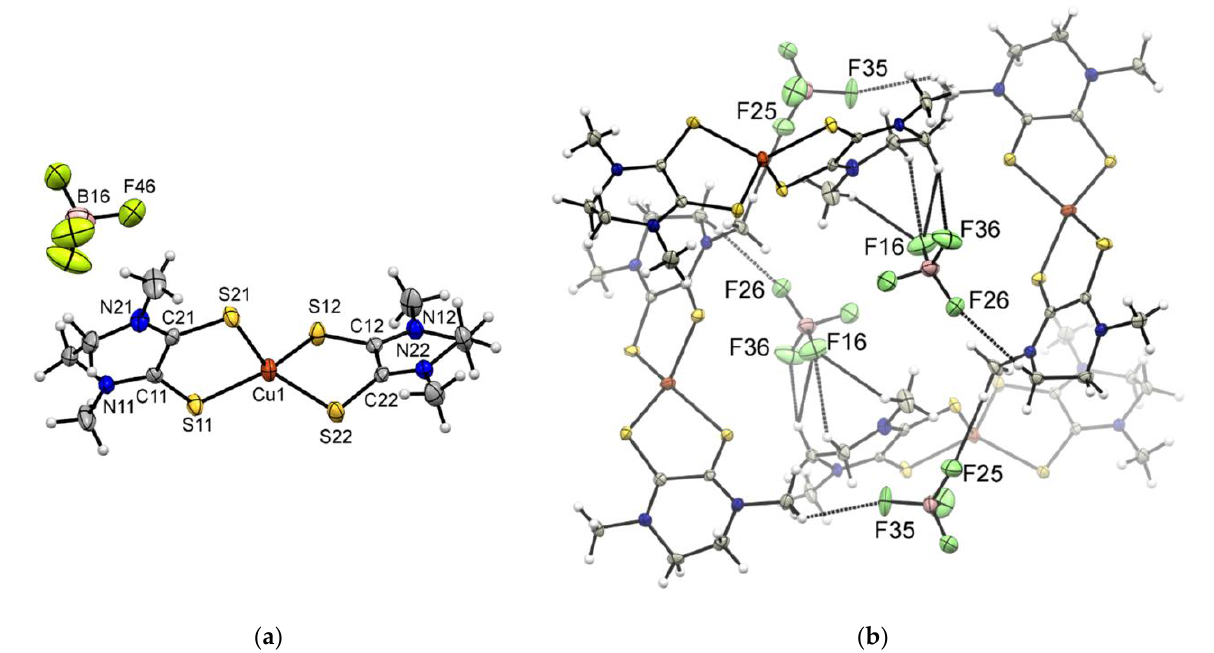
Figure 4. ( a ) Molecular structure of complex [Cu(Me 2 pipdt) 2 ]BF 4 ( 4 ) with thermal ellipsoids plotted at the 50% probability level. One molecular entity of the two comprising the asymmetric unit is reported for clarity. ( b ) Portion of the crystal packing, showing intermolecular interactions as dashed bonds.